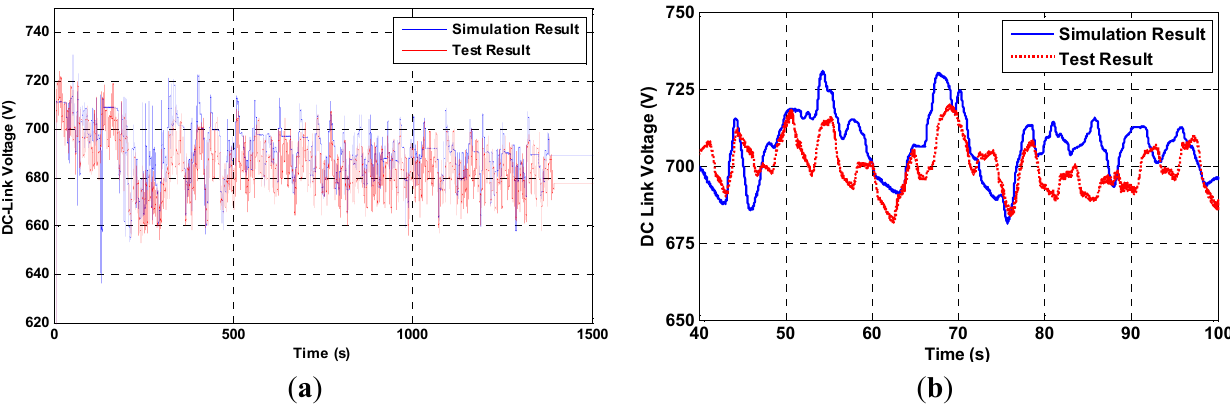
Figure 11. Battery characteristics evaluation result: ( a ) Entire cycle; ( b ) Partially close-up.